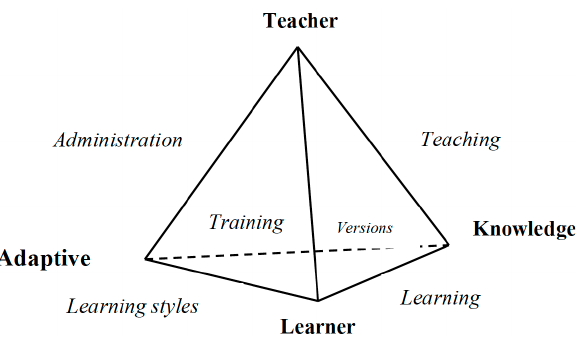
Figure 4. The didactic tetrahedron of Lombard